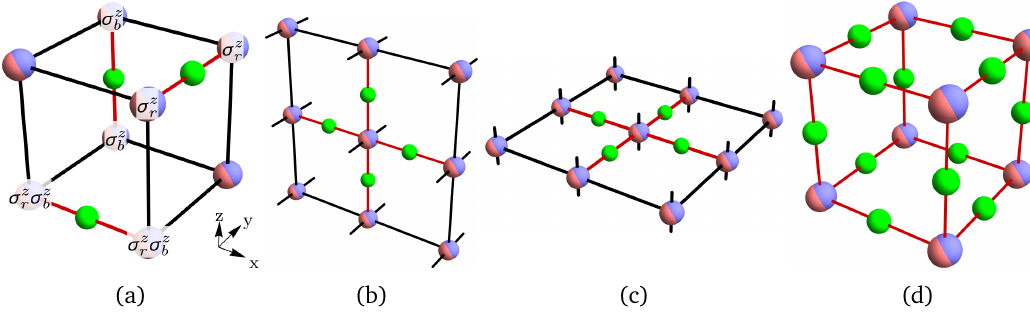
Figure 8: Gauging planar symmetry on the cubic lattice with lineon charges. (a) The three minimal coupling terms, which are each a product of σ z operators across one of the red links. (b) A σ z operator at the center is included in four minimal coupling b terms on the red links. The corresponding gauge symmetry term is a product of a σ x at the center and τ x operators on the green spheres. (c) Same as (b), but for σ z b (d) The flux term is a product of τ z on the twelve green